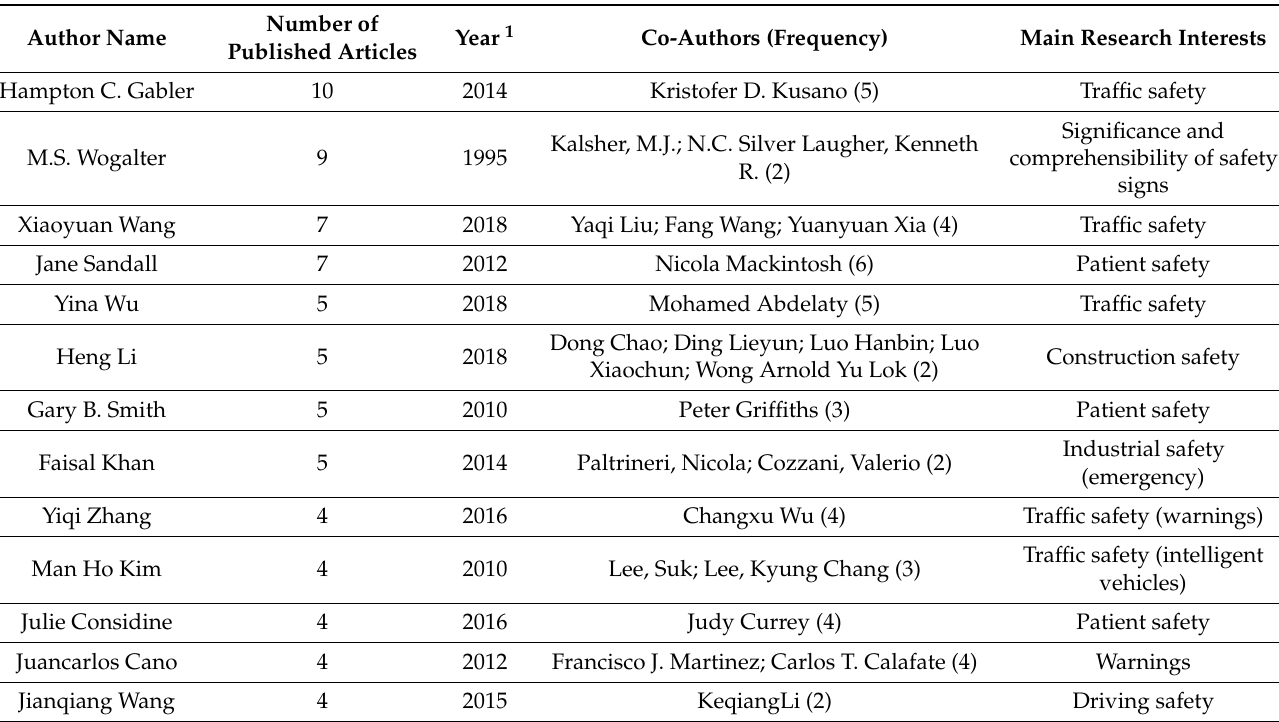
Table 1. Cooperation and research interest of the main authors of safety signs.